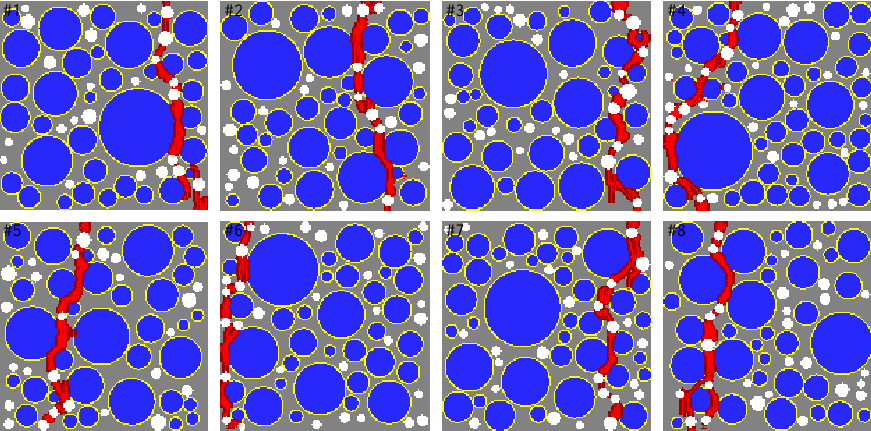
Figure 21. Crack pattern for selected specimens with P pore = 6% and P agg =